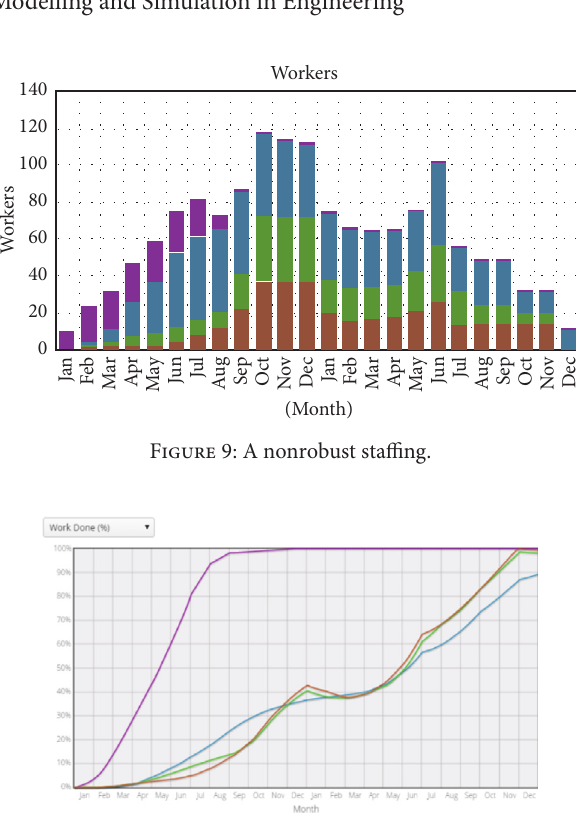
Figure 10: The progress outcome estimate of the nonrobust